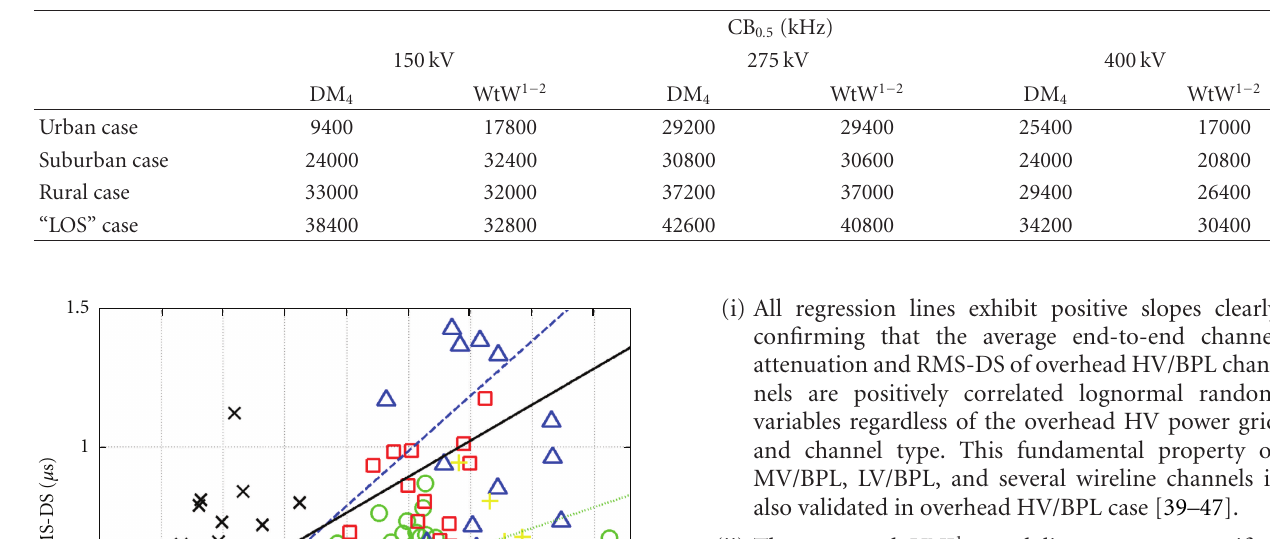
Table 3: CB 0 . 5 for various overhead HV/BPL configurations and topologies.